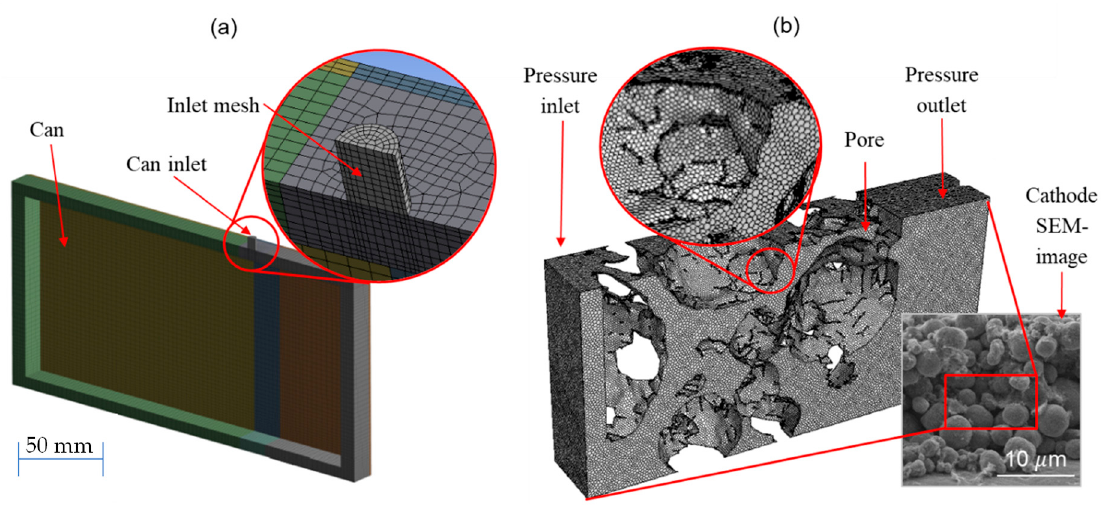
Figure 2. Overview of half of the void volume used during simulations of the macro scale ( a ) including the detailed view of the critical inlet section with a modified mesh of the electrode volume and SEM image of a NMC cathode ( b ).